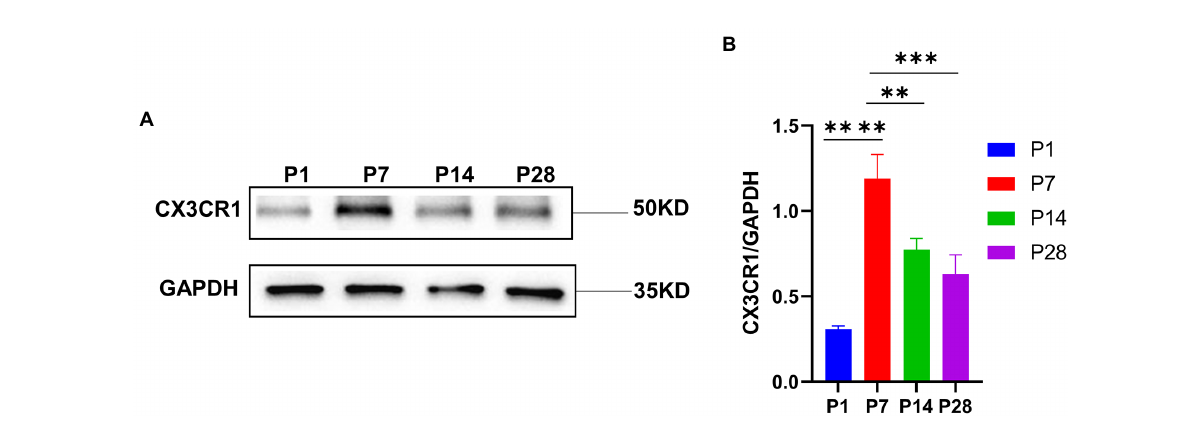
FIGURE 4 (A) CX3CR1 expression in the cochlea of postnatal mice is determined by western blotting. A significantly stronger band is identified around P7 than in P1, P14, and P28 ( n = 3). (B) Quantitative analysis of CX3CR1 expression from P1 to P28 showing that the ratio of CX3CR1 to GAPDH is significantly higher in P7 than in P1, P14, and P28. **** p < 0.0001, ** p = 0.0019, *** p = 0.0003. GAPDH is used as the loading control ( n =